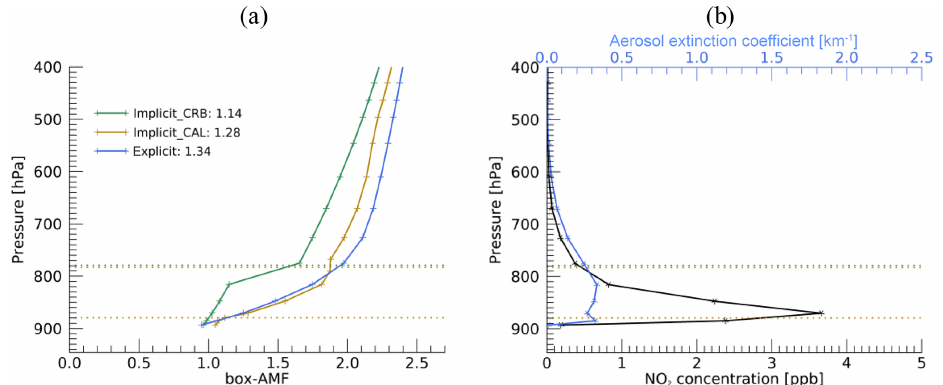
Figure 17. Similar to Fig. 16 but for Bujumbura station on 9 September 2015. The cloud radiance fraction is 0.18, the cloud optical depth is 4.83, the aerosol optical depth is 0.58, the SZA is 40 ◦ , the VZA is 14 ◦ , and the RAA is 155 ◦